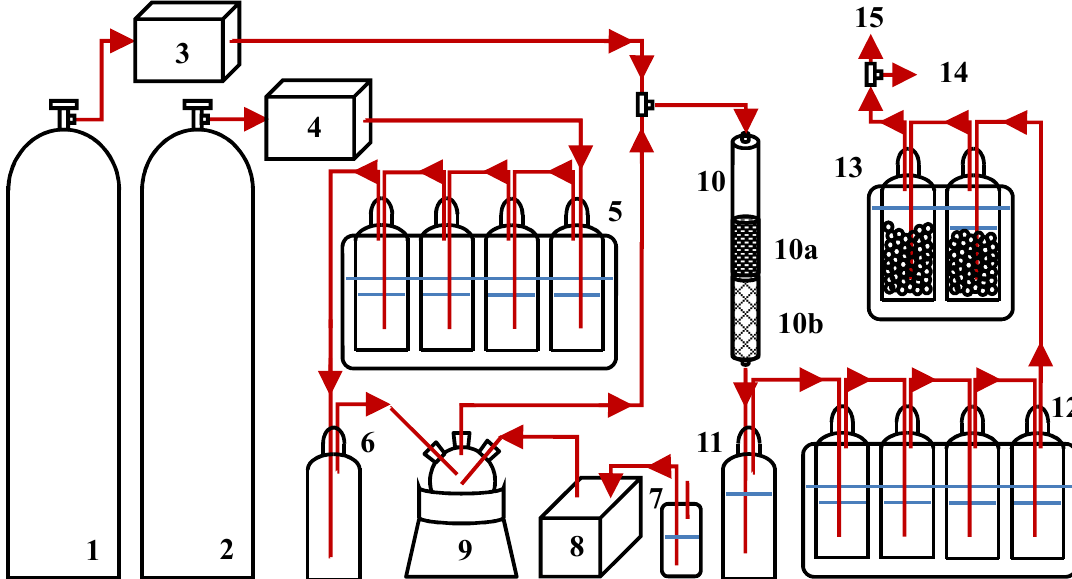
Figure 5. Flow-sheet of unit used for model tar component catalytic decomposition: pressure cylinders with N 2 ( 1 ) and CO 2 ( 2 ), mass flow-meters ( 3, 4 ), thermostated (28 °C) scrubbers for gas phase saturation with water vapor ( 5 ), scrubber for water droplets separation ( 6 ), p -xylene reservoir ( 7 ), peristaltic pump ( 8 ), heated (150 °C) flask for p -xylene evaporation ( 9 ), electrically heated reactor ( 10 ) with catalytic ( 10a ) and supporting ( 10b ) layers, scrubber with IPA at ambient temperature ( 11 ), thermostated (37 °C) scrubbers with IPA for capture of condensable components from gas phase ( 12 ), cryostated (–20 °C) scrubbers with IPA and glass balls ( 13 ), gas phase sampling port ( 14 ), wet gas flow meter and exhaust ( 15 ).